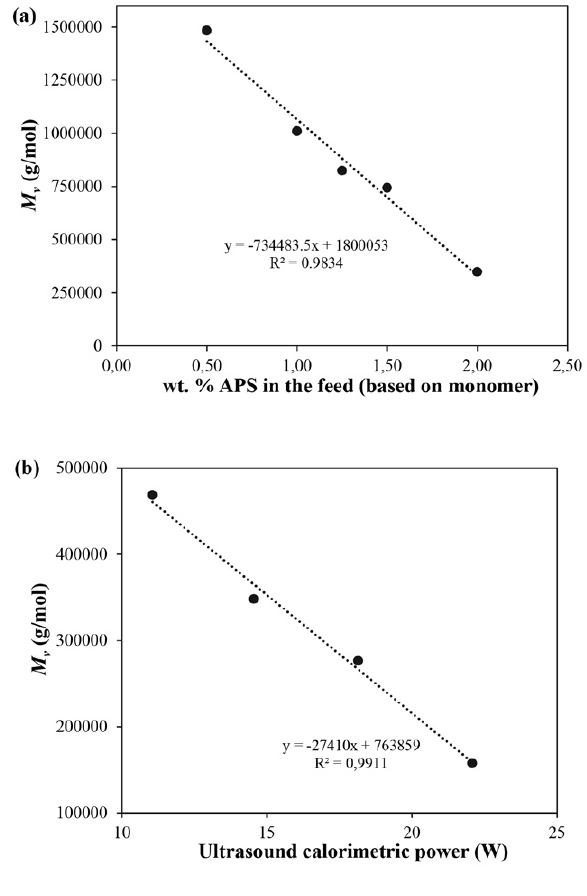
Fig. 6. (a) Change of viscosity average molecular weight with the change of weight fraction of APS in the feed (Ultrasound calorimet- ric power: 14.6 W, SDS: wt. % 0.5, [M] 0 = 0.5 M), (b) Change of viscosity average molecular weight with the change of ultrasound power (APS: wt. % 2, SDS: wt. % 0.5, [M] 0 =0.5